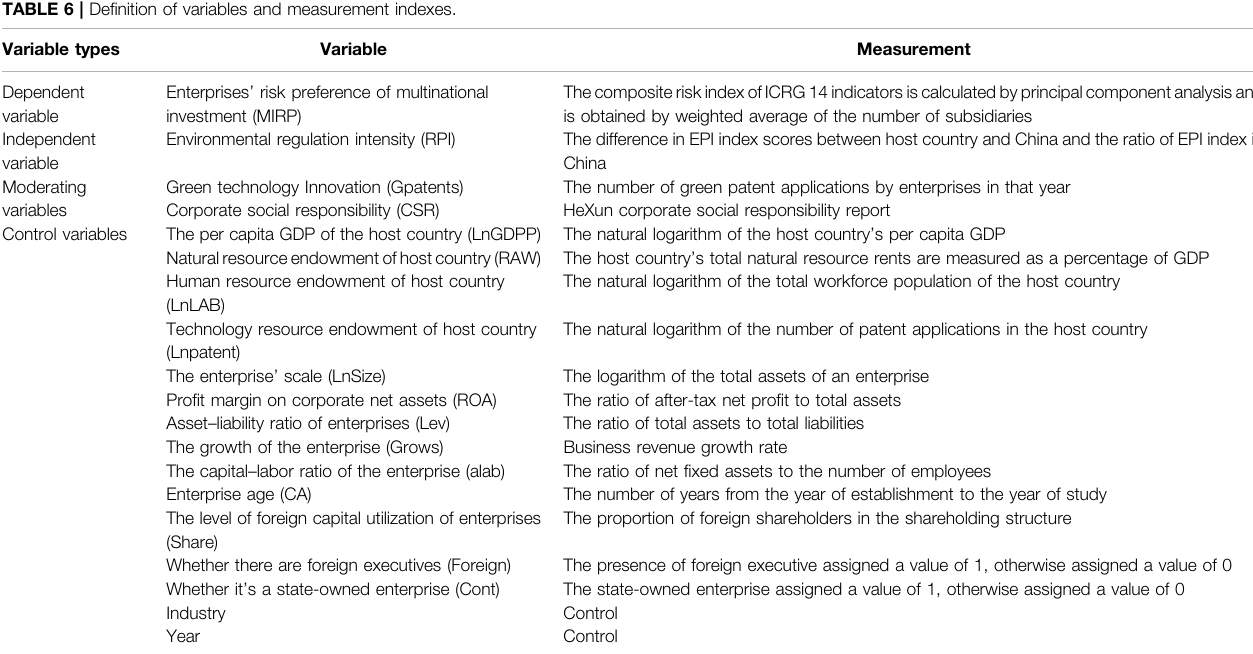
TABLE 6 | De fi nition of variables and measurement